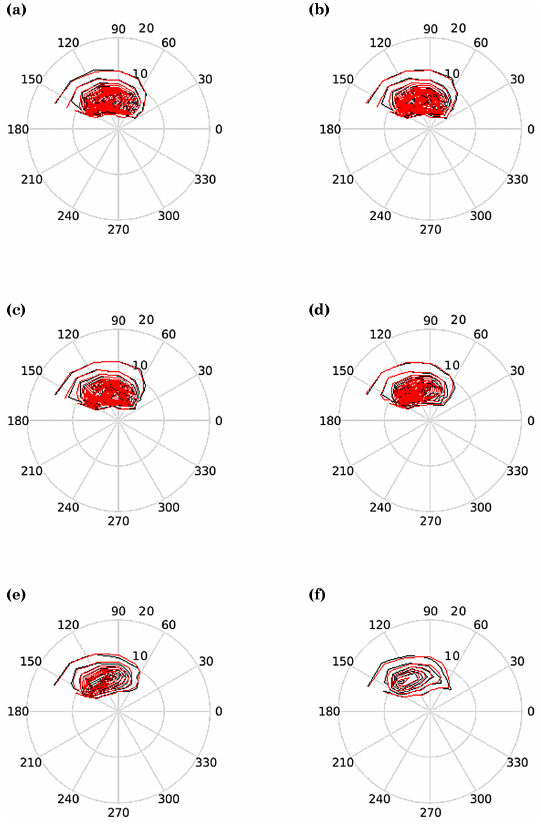
Figure 24. Polar plot of the modelled 2-D directional spectrum (en- ergy density, m 2 × s / degrees) in the Aberdeen wave gauge, red in- dicates the contour plot of the coupled model spectrum (with WCIs incorporated), while black indicates the contour plot of the uncou- pled model. Contour lines are plotted every 0.01m 2 sdegrees − 1 : (a) 31 March 2010 at 00:30, (b) 31 March 2010 at 01:15, (c) 31 March 2010 at 02:00, (d) 31 March 2010 at 04:15, (e) 31 March 2010 at 06:00, and (f) 31 March 2010 at